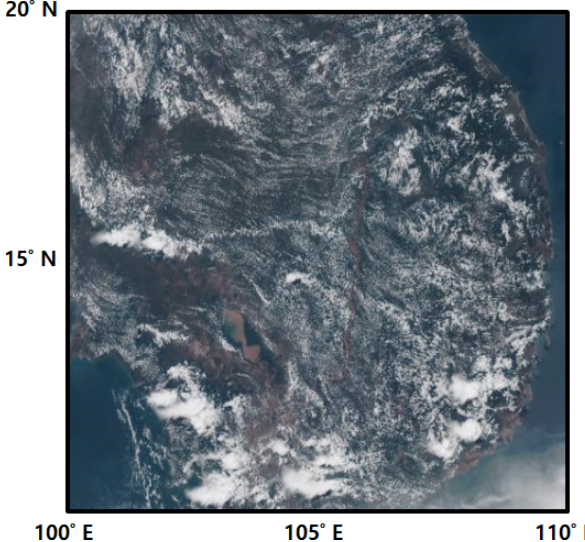
Figure 1. Himawari-8 AHI RGB image taken for this study area on 19 August 2015 at 05:50UTC. Several convective clouds (pictured in white) are visible in the southern part of the